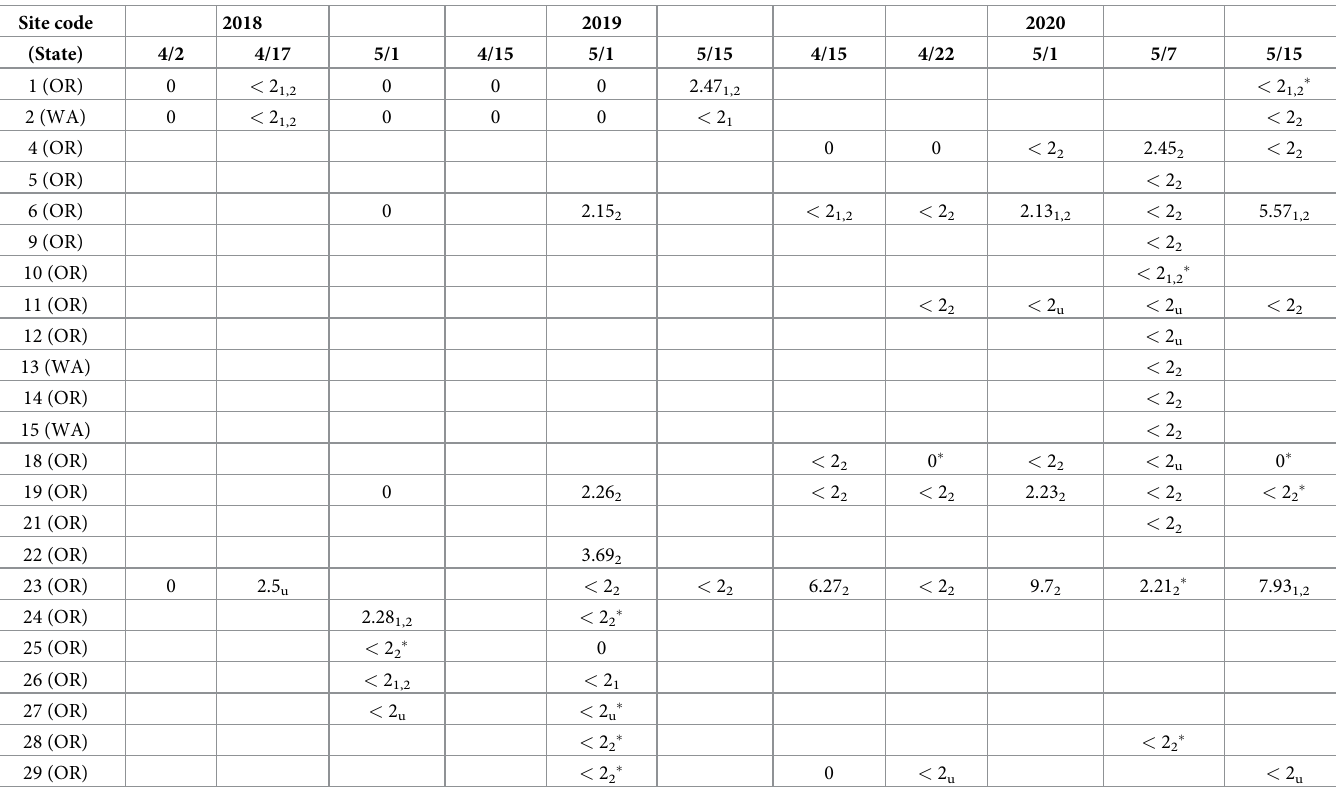
Table 3. Sample site code, Ceratonova shasta density (spores/ L), and genotypes (subscript 1 = I, 2 = II, u = unknown) measured at Columbia River sites 2018–2020. The table excludes the first two sample events in 2018 as no C . shasta was detected. The table also excludes sample sites where C . shasta was never detected. Empty cells indicate the site was not sampled during a particular sample event.